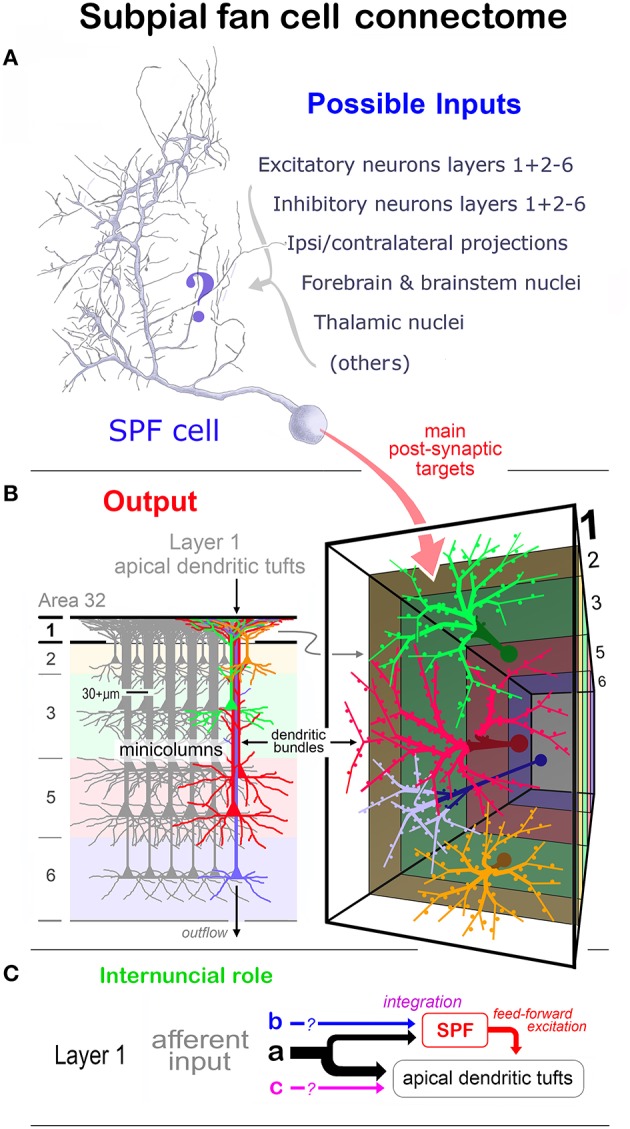
(A) Schematic diagram showing possible sources of synaptic input (?) to SPF cells. (B) Diagram illustrating the organization of pyramidal cell bodies in agranular area 32 into radial minicolumns (spaced 30+μm apart in adult monkey PFC). The apical dendrites of pyramids in layers 3–6 form bundles as they ascend through the cortex. Layer 2 pyramids contribute to a separate bundling system. Each bundle gives rise to a spray of apical dendritic tufts — the main post-synaptic targets of SPF cells. (C) Internuncial role of SPF cells. Extrinsic and intrinsic axonal systems in layer 1 provide common input (a) to the apical dendritic tufts of pyramidal cells and SPF cells. This input may be differentially distributed across cell types. However, SPF cells and dendritic tufts may (?) receive additional input from specific sources (b/c respectively). SPF cells are strategically placed to integrate afferent input and provide a feed-forward excitation influencing neural activity in target apical dendritic tufts.